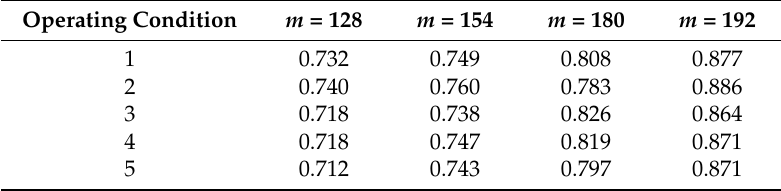
Table 2. The correlation coefficients between different reconstructed signals and original